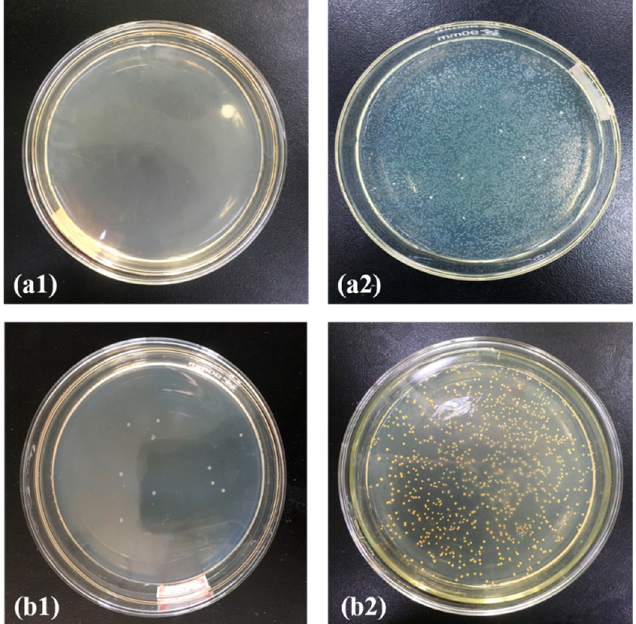
Figure 9. Ag@ZIF-8@ melt-blown nonwoven fabric electrostatic electret antibacterial test charts: ( a ) E. coli test chart, ( b ) Staphylococcus aureus test chart, 1. electrostatic electret treatment, and 2. non-electrostatic electret treatment.